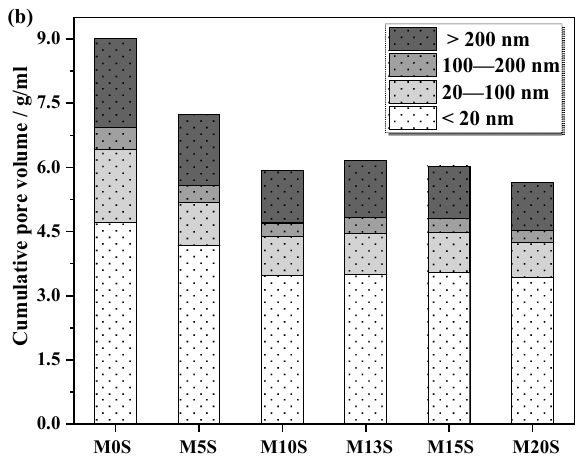
Figure 7. Pore structure of 28d MASM mortars : ( a ) differential pore-size distribution; ( b ) cumulative porosity.